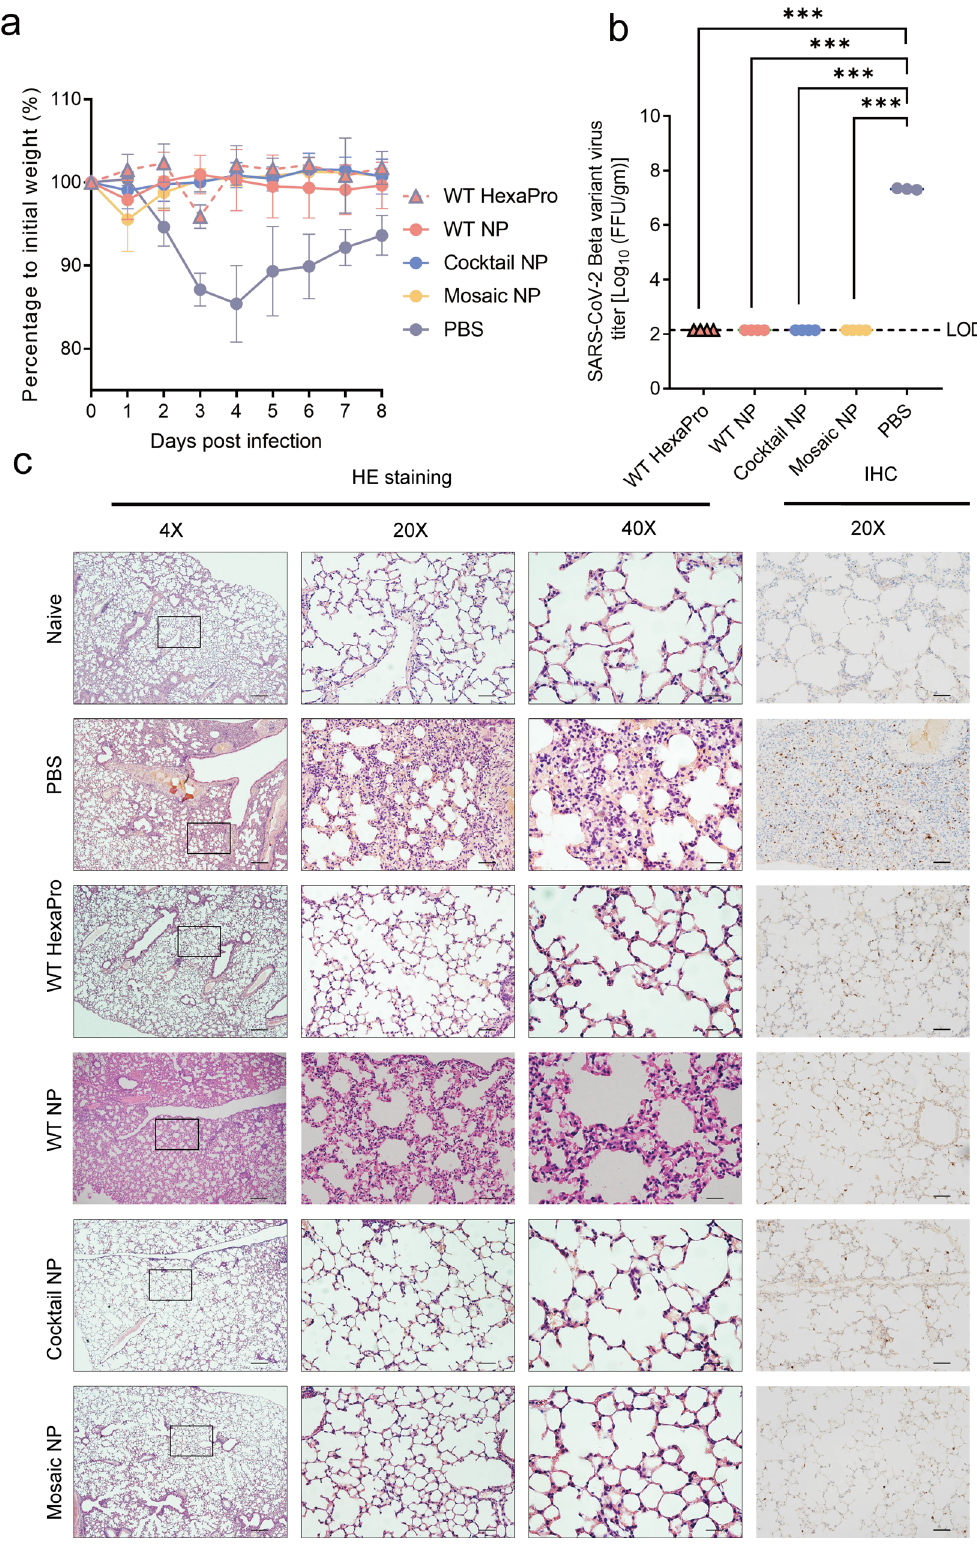
with broad target antigen may be the viable solutions for immune escape of SARS-CoV-2 variants. Previous studies showed that mice immunized with mosaic SARS-related RBD-based nano- particle vaccine could be elicited broadly antibody response to SARS-CoV-2 and SARS-related emergent zoonotic coronaviruses 23,50 . And rhesus macaques vaccinated with